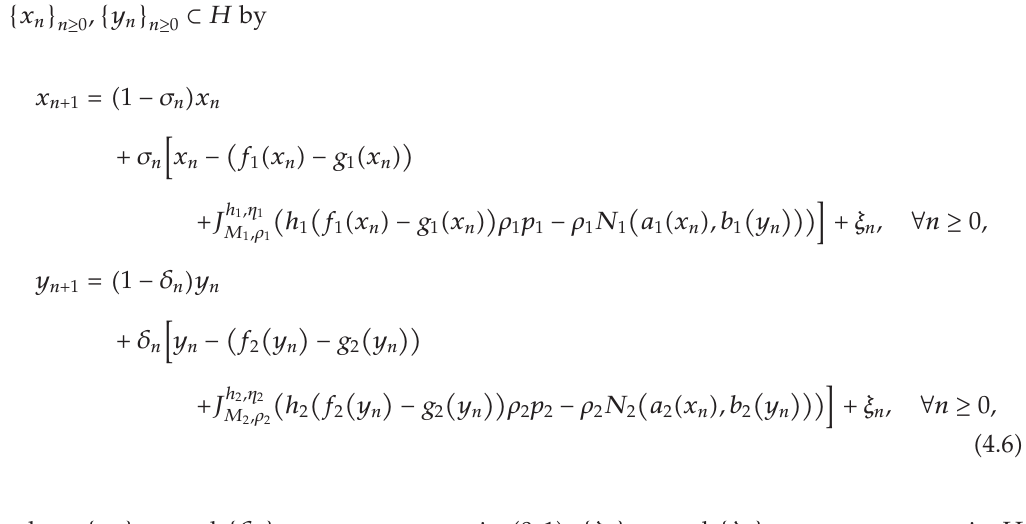
Algorithm 4.2 (cid:4) The Mann iteration method with errors (cid:5) . For any x 0 , y 0 ∈ H , compute